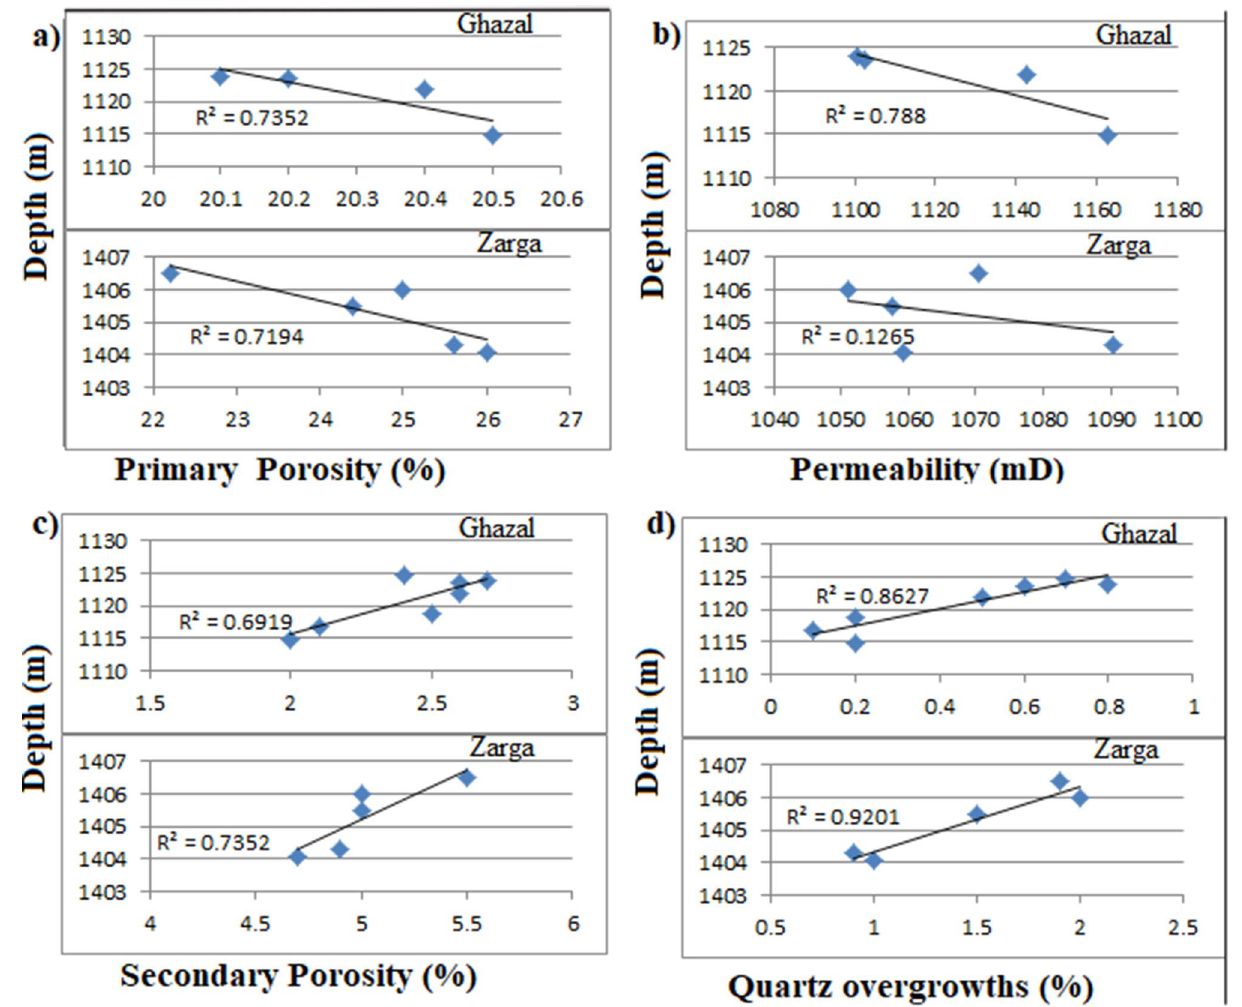
Figure 15. ( a ) Cross-plots of primary porosity and permeability values against burial depth, ( b ) showing that porosity and permeability decrease with increasing burial depth. ( c ) Secondary porosity displaying a positive trend with increasing burial depth. ( d ) Shows the amounts of quartz overgrowths increase with increasing burial depth.